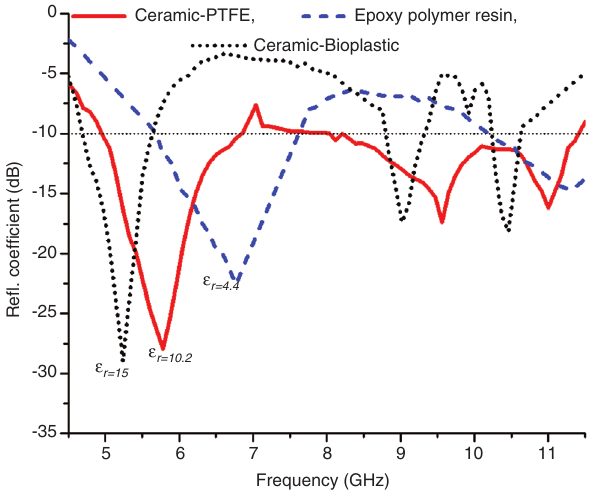
Figure 4 Effect of dielectric property of substrate materials on reflection coefficient.